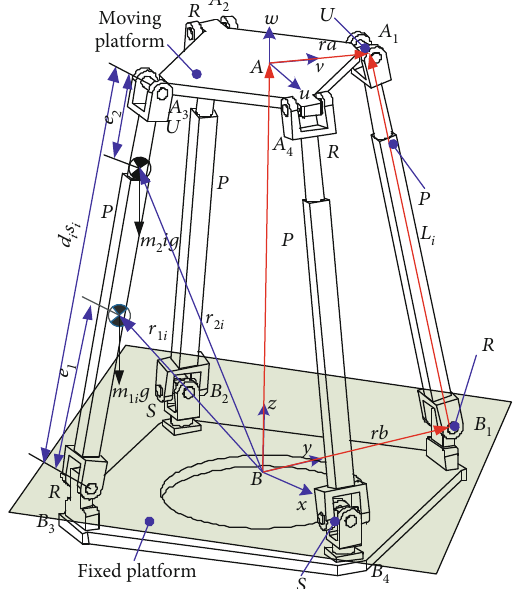
Figure 2: Schematic diagram of the 2RPU-2SPR parallel